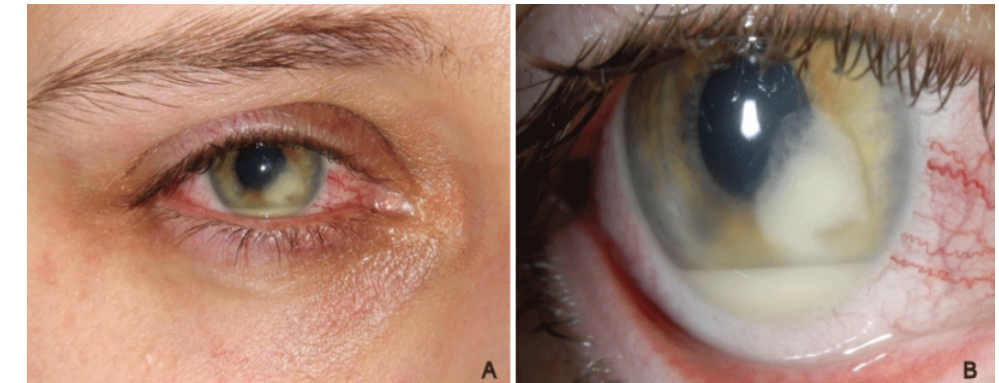
Figure 1: Slit-lamp photo of the right eye showing hypopyon and fungal mass in the anterior chamber (day 1)